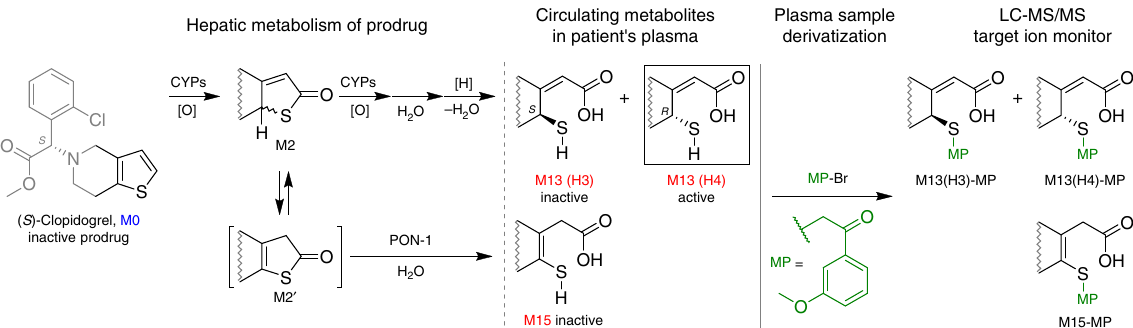
Fig. 1 Metabolic activation of CPG in patients. The prodrug forms three circulating thiol metabolites (M13-H3, M13-H4 and M15) after hepatic